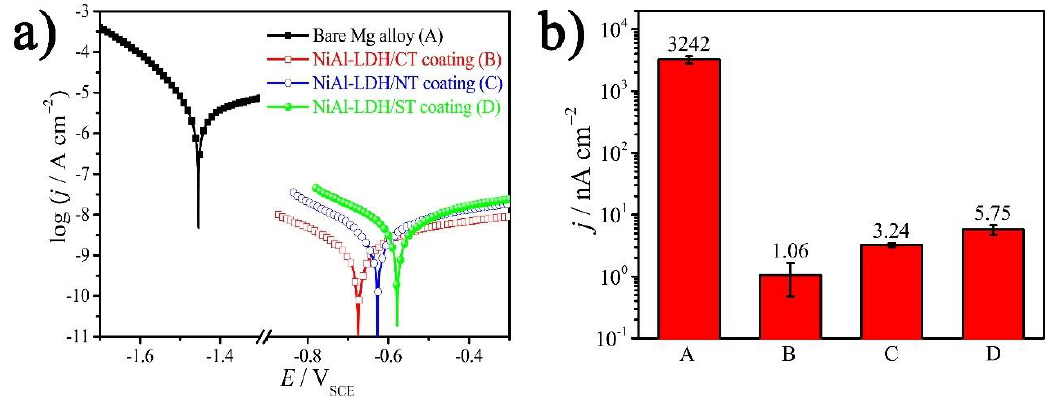
Figure 7. ( a ) Tafel curves of the bare Mg alloy and different NiAl-LDH coatings in NaCl corrosive medium. ( b ) The corresponding j corr of substrate and coatings extracted from the Tafel curve. Table 3. Parameters of Tafel curves for bare Mg alloy and different NiAl-LDH